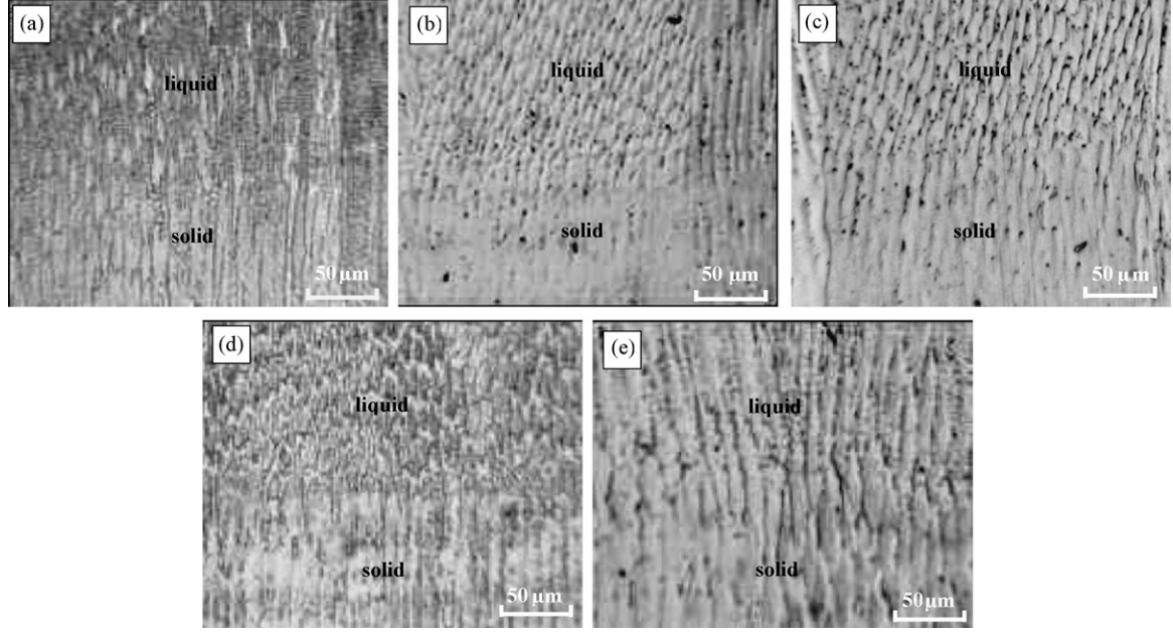
Figure 21. Longitudinal microstructure at the pulling rate of 96 μ m/ с with different magnetic intensity: ( a ) 0 T, ( b ) 0.50 T, ( c ) 0.84 T, ( d ) 1.00 T, and ( e ) 1.50 T [21].